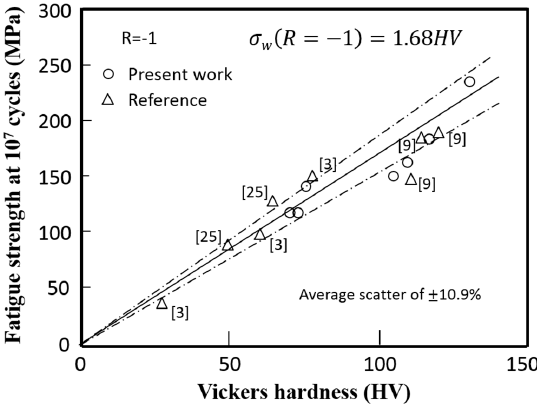
Figure 13. Relationship between the fatigue strength under R = − 1 at 10 7 cycles and hardness.